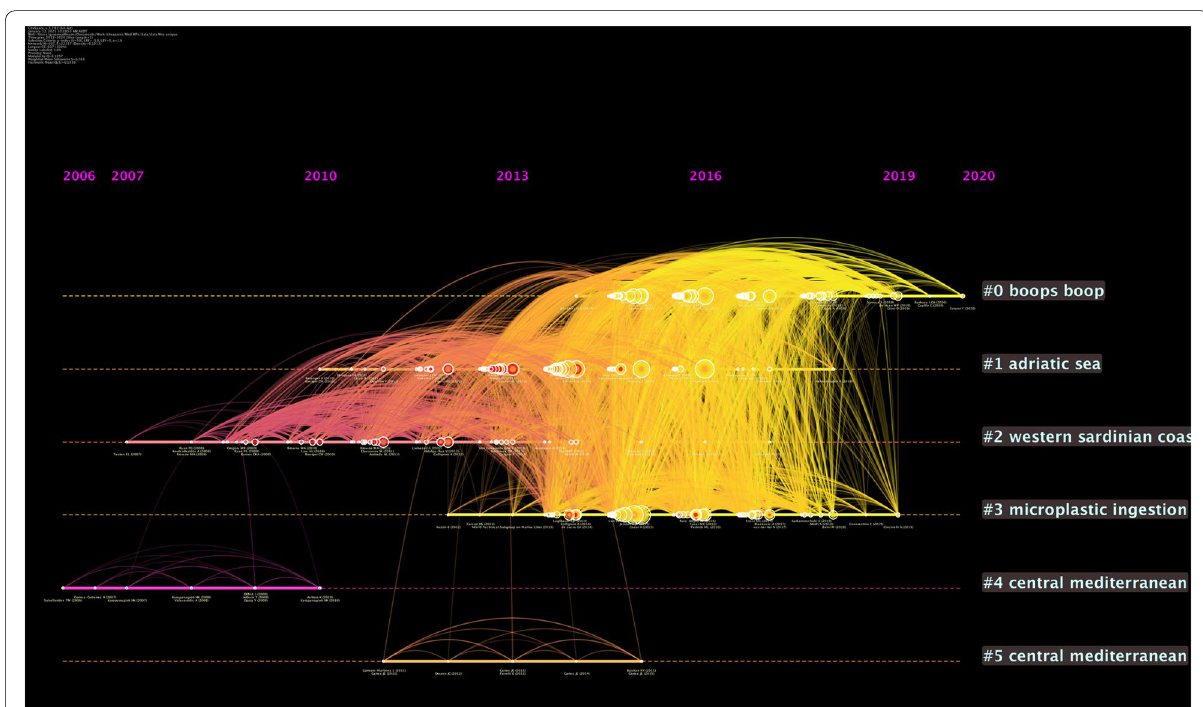
5). Nodes represent = 0.1057, average =